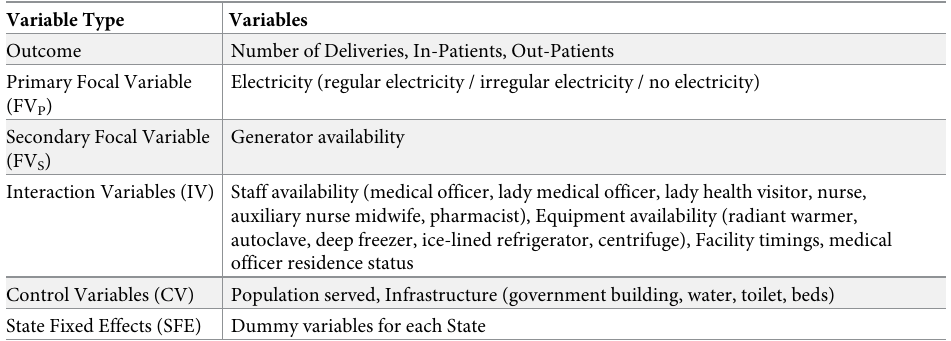
Table 2. List of variables used in the empirical models.